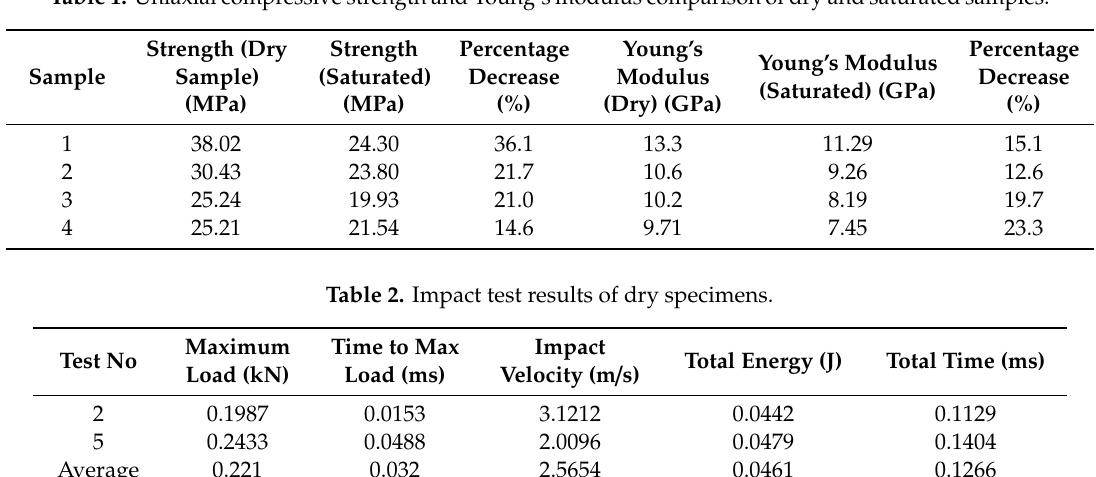
Table 1. Uniaxial compressive strength and Young’s modulus comparison of dry and saturated samples.